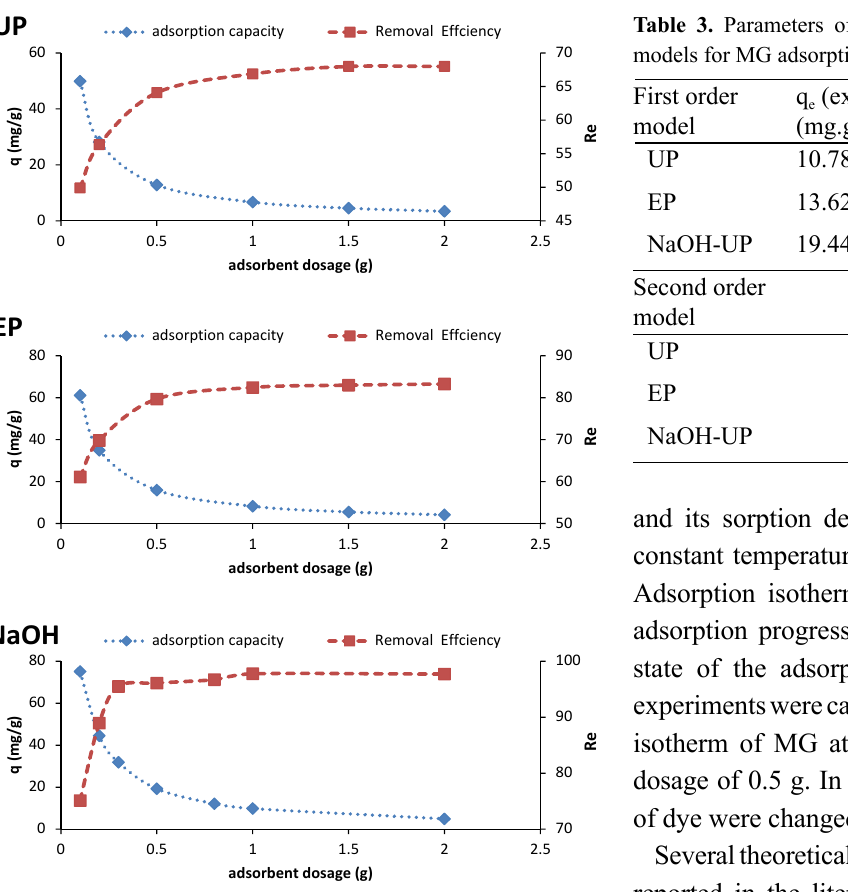
Fig. 6. Effect of adsorbent dosage on MG adsorption onto UP, EP and